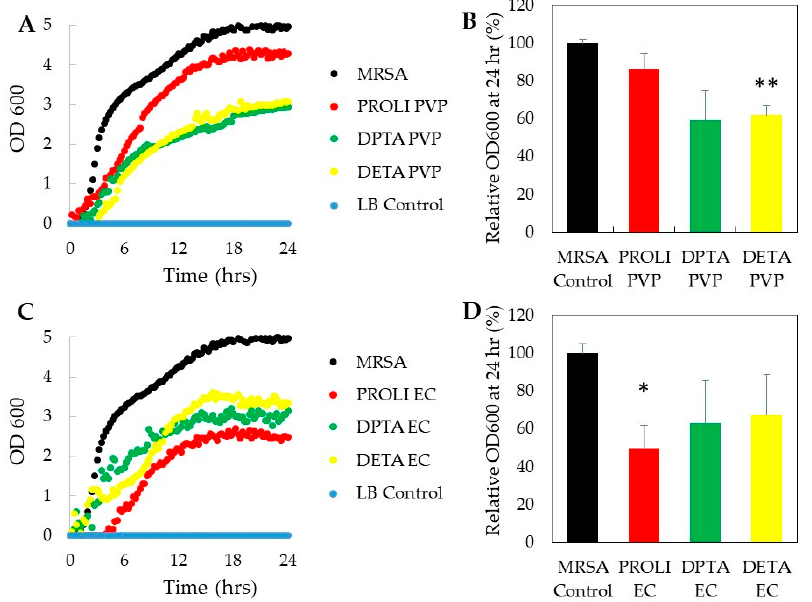
Figure 4. Antimicrobial effect of NO-fibers on MRSA. Growth curves of MRSA treated with PVP NO-fibers ( A ) and EC NO-fibers ( C ) over 24 h were measured as optical density at 600 nm. The viability of MRSA at 24 h was compared to the untreated control following treatment with PVP NO-fibers ( B ) and EC NO-fibers ( D ). Data are shown as mean ± SD. n = 3 statistical significance: * p < 0.05, ** p < 0.01.